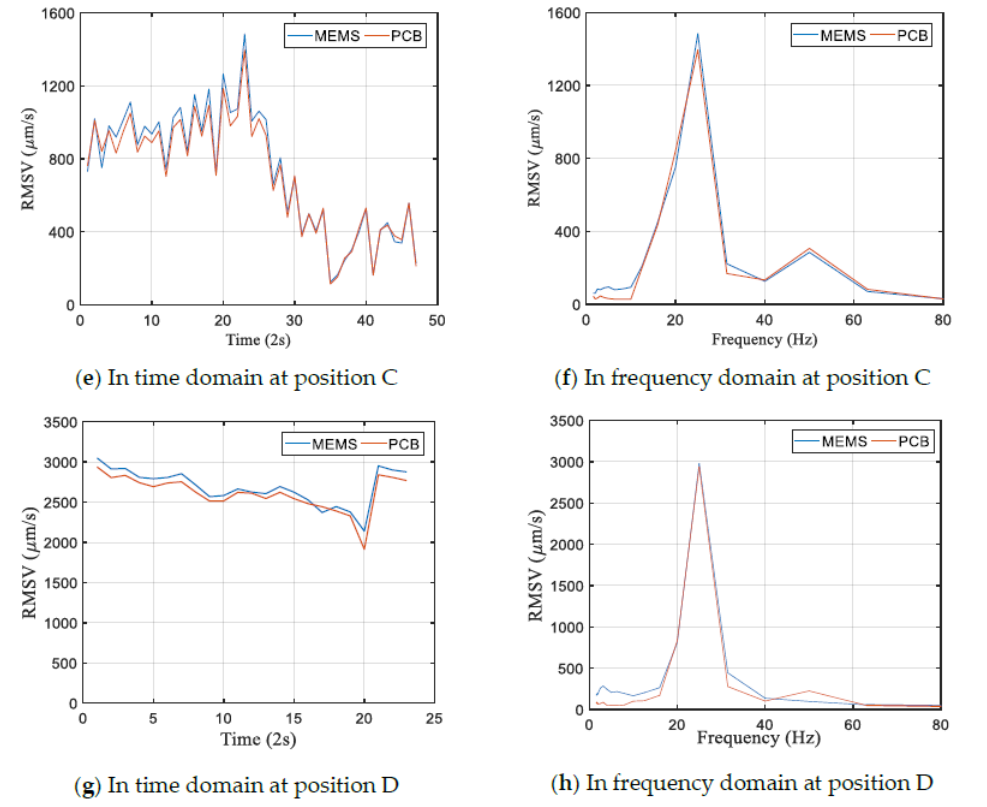
Figure 17. RMS velocity in the 1 / 3 octave band in time and frequency domain.